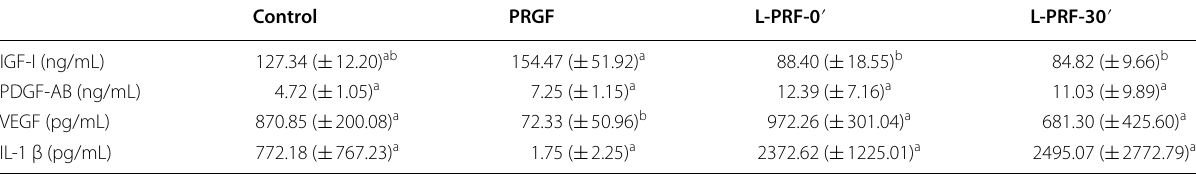
Equal letters show that there are no statistically significant differences within groups. Note that comparisons refer exclusively to data in the same row